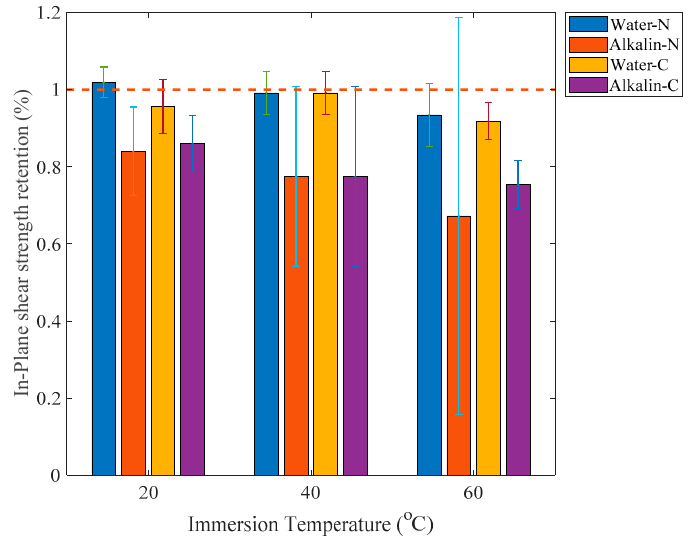
Figure 19. In-Plane shear strength retention of specimens immersed for three months.